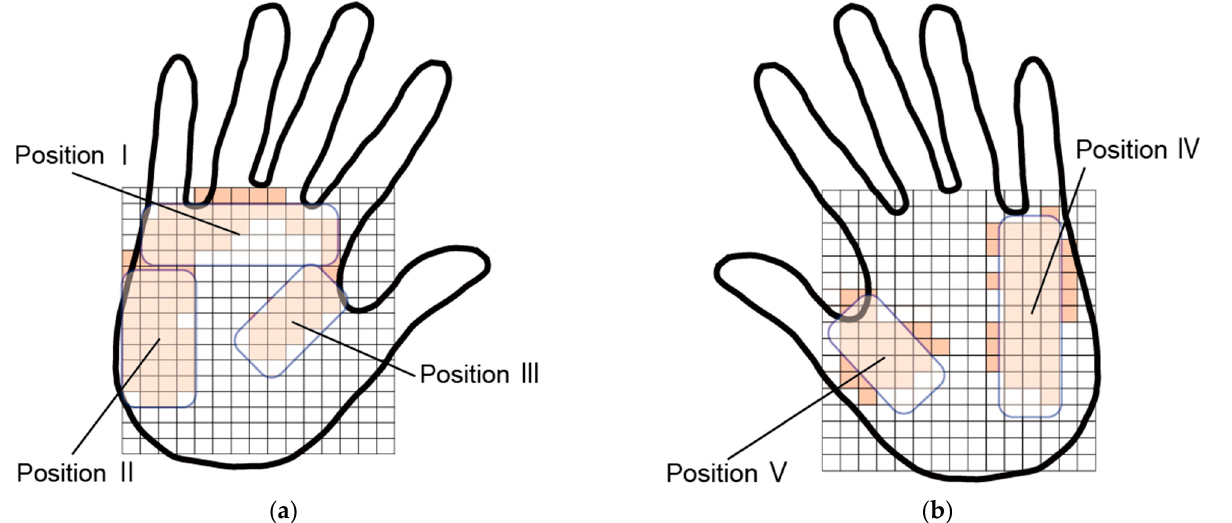
Figure 7. Deduced contact areas during handshake: ( a ) Palm of the hand. ( b ) Back of the hand.